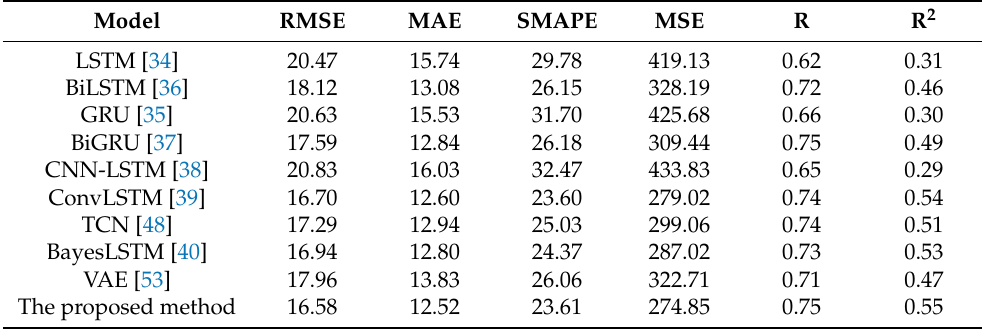
Table 3. Accuracy evaluation of prediction results of each model on the humidity dataset.